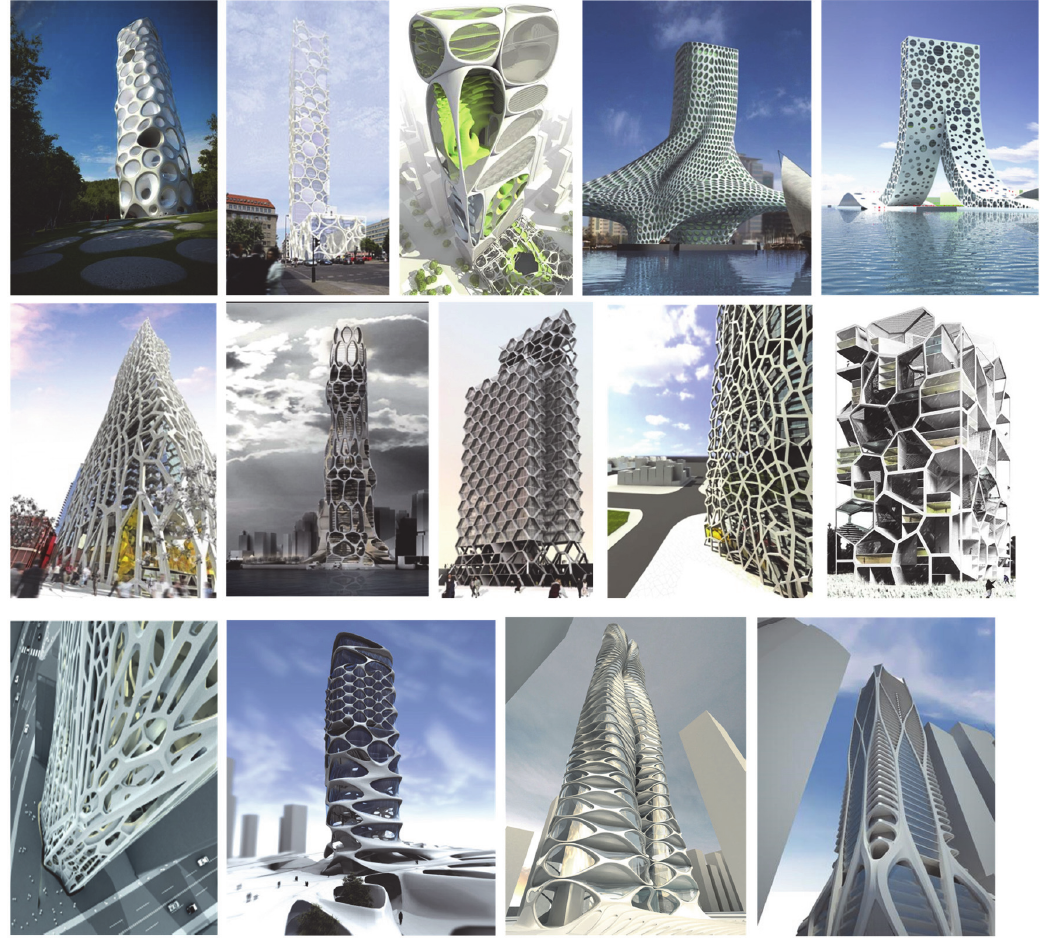
Figure 1: Examples of non-conventional structural